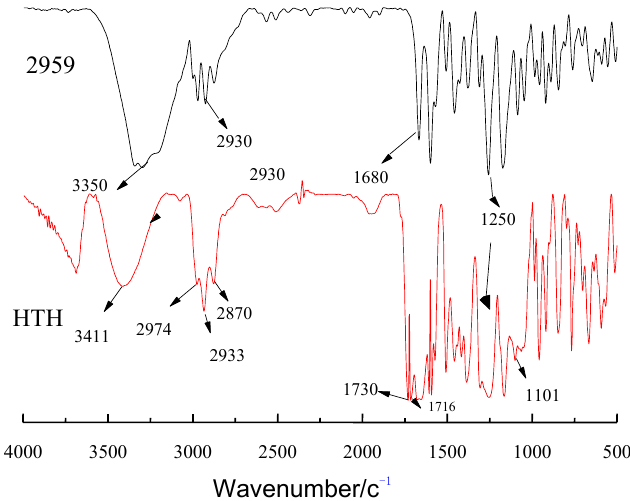
Figure 2. FTIR spectra for HTH and